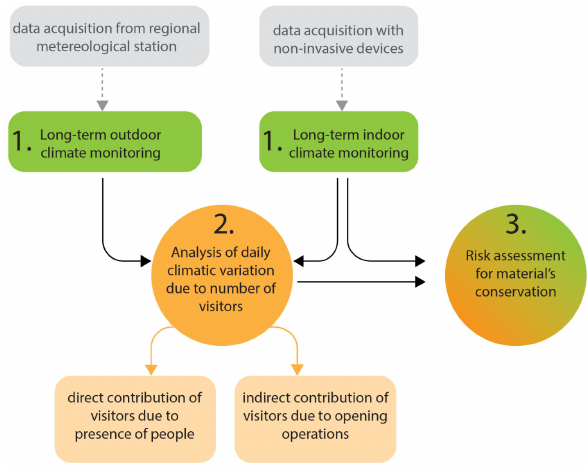
Figure 2. Flowchart of the method